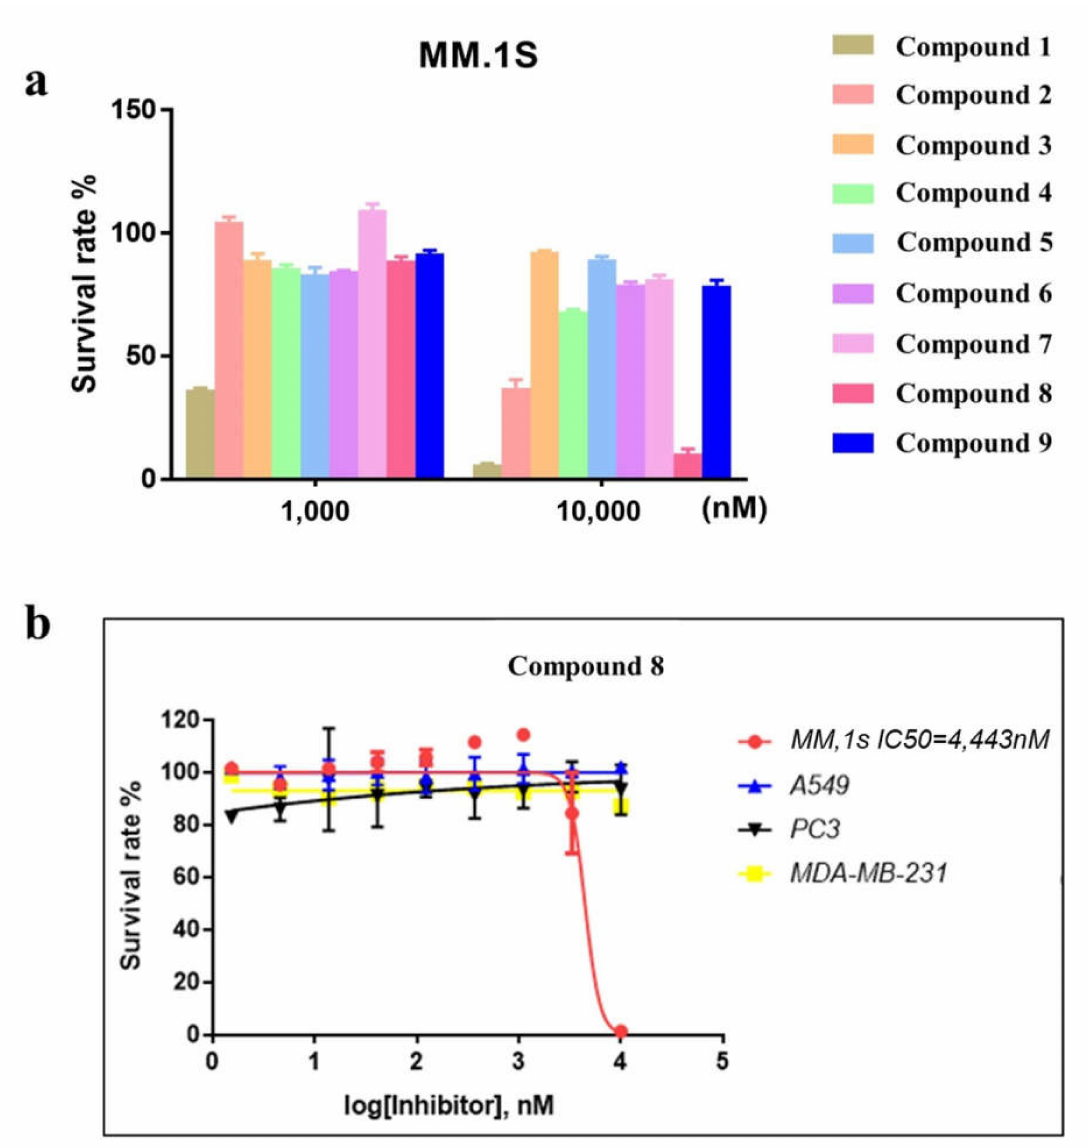
Figure 4. ( a ) Compounds 1 , 8 , and 9 exhibited optimal XPO1 inhibitory activity in three independent sets of cell proliferation assays. ( b ) Inhibition of proliferation in MM.1S, A549, MDA-MB-231, and PC3 cell lines by compound 8 treatment after 48